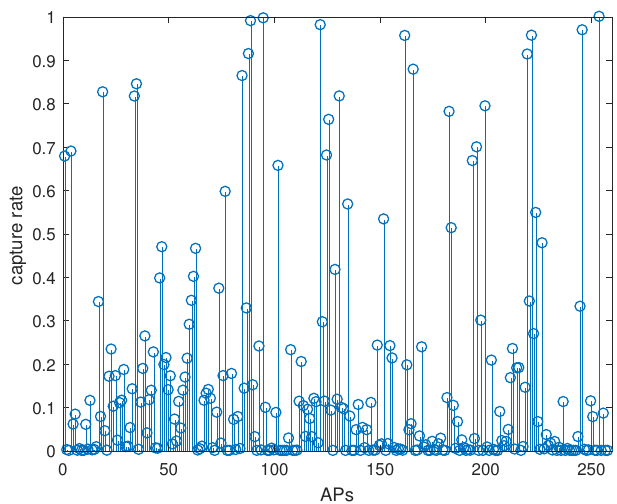
Figure 10. AP capture rate of RP point.